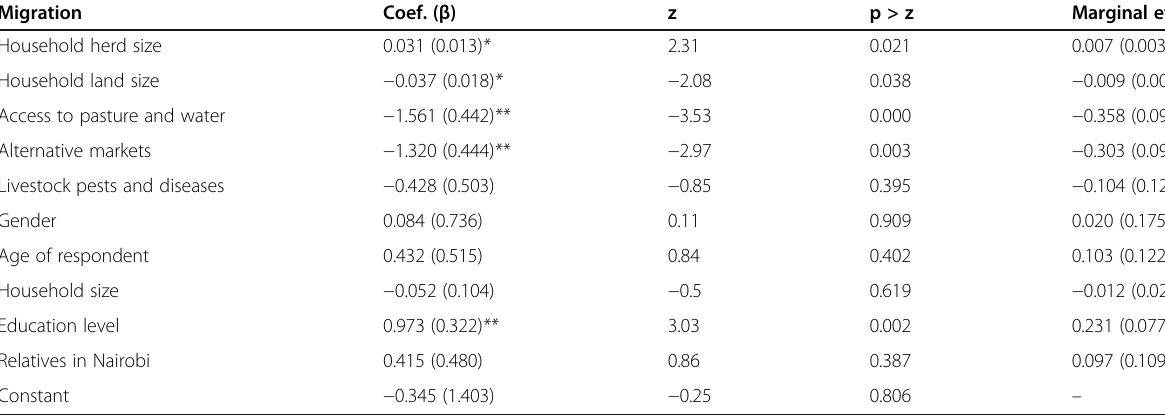
Table 4 Logit model estimates for pastoralist migration to the city Migration